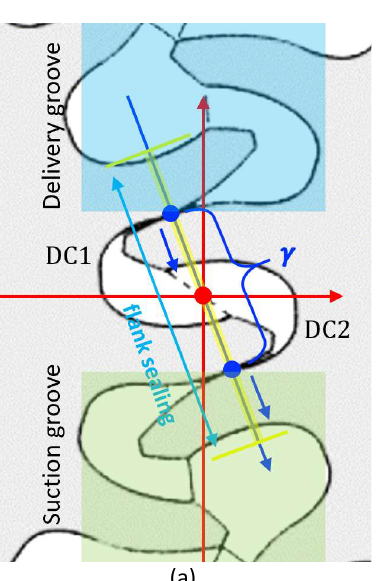
Figure 14. Three volume-curve based porting design: maximum delivery ( left ), minimum delivery ( middle ) and intermediate delivery porting design ( right ).